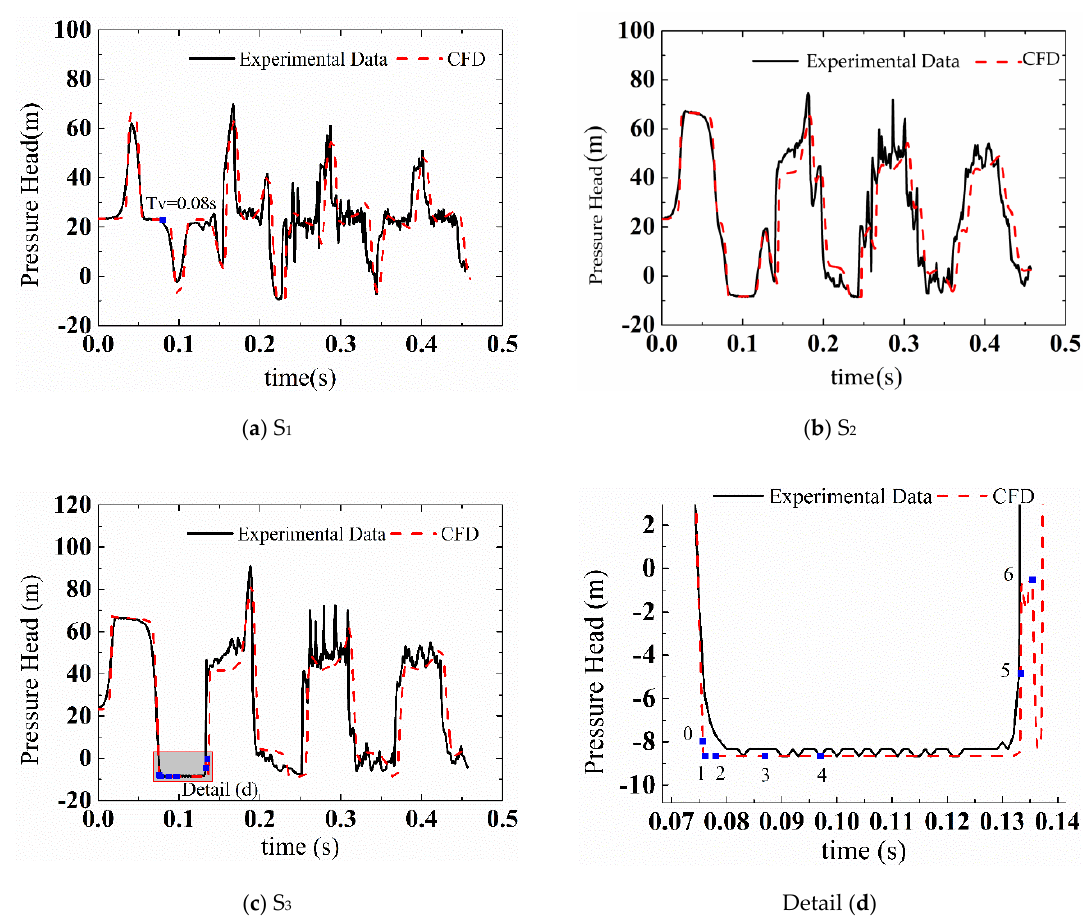
Figure 26. Comparison between Computational Fluid Dynamics (CFD) simulation results and experimental data.